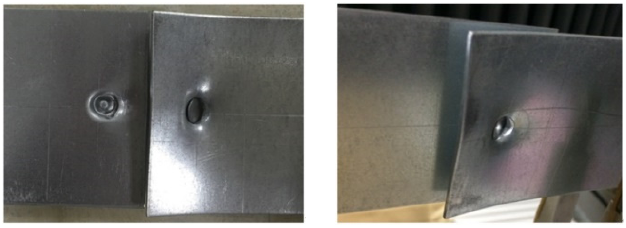
Figure 12. The failure mode of test specimens.